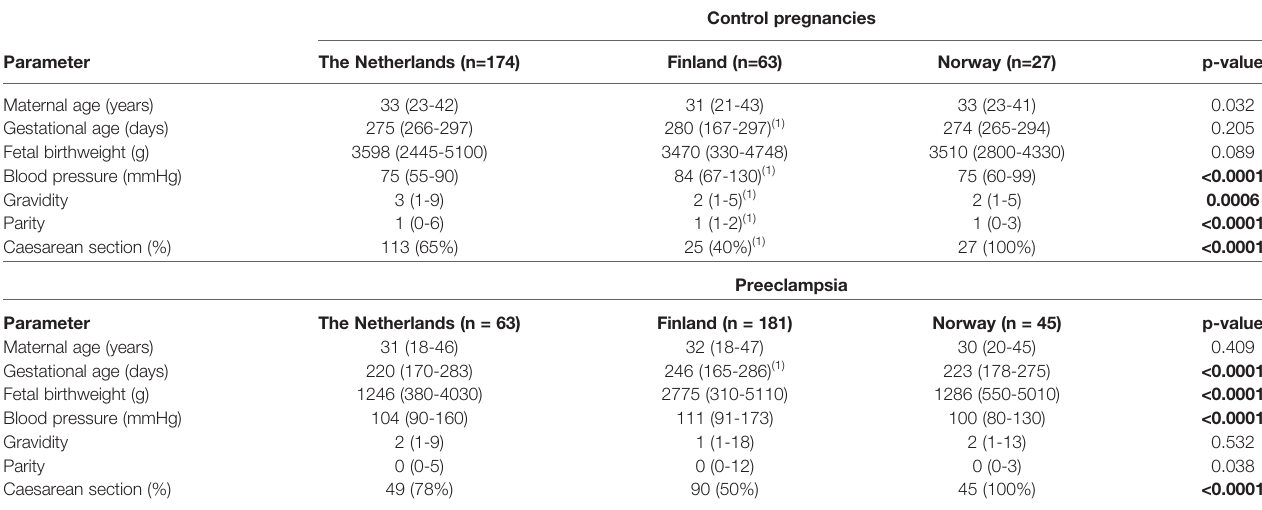
TABLE 2 | Comparison of clinical characteristics between the three independent cohorts in control pregnancies and in PE